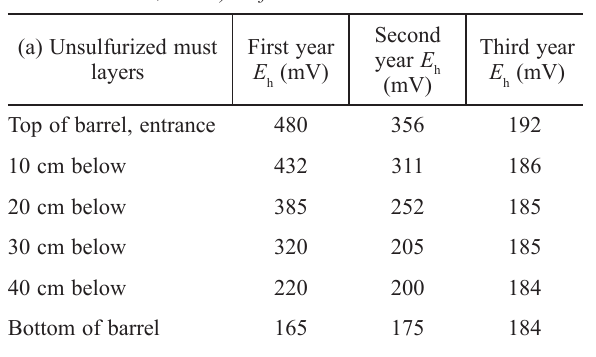
Table 2 – Results of chemical analysis of sulfurized and un- sulfurized wines after three years at the end of